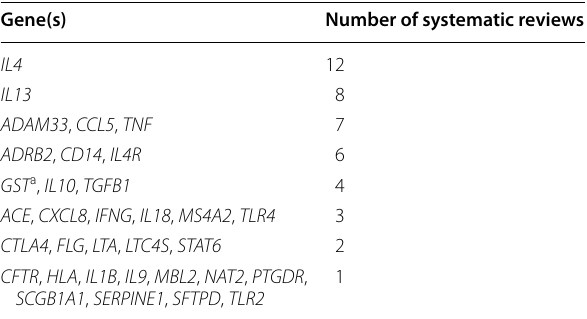
Table 1 Genes along with the frequency they were cov- ered by systematic